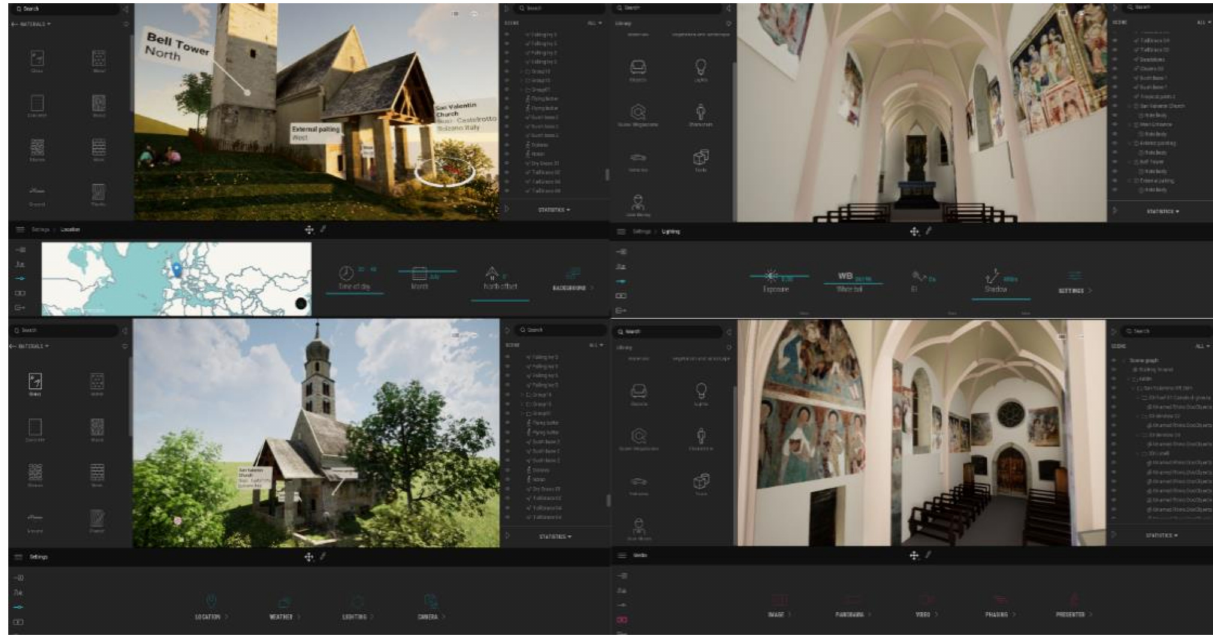
Figure 9. The VR project of San Valentino church in Twinmotion. On the right external view and on left internal view of the